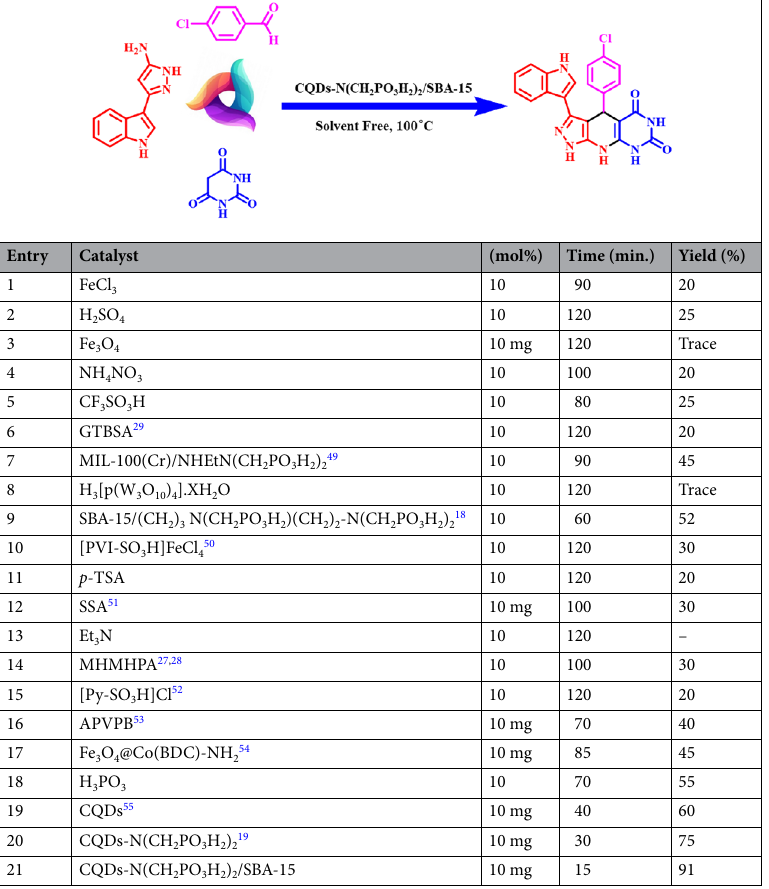
Table 4. Synthesis of pyrazolo[4 ′ ,3 ′ :5,6]pyrido[2,3- d ]pyrimidines in the presence of various catalysts.